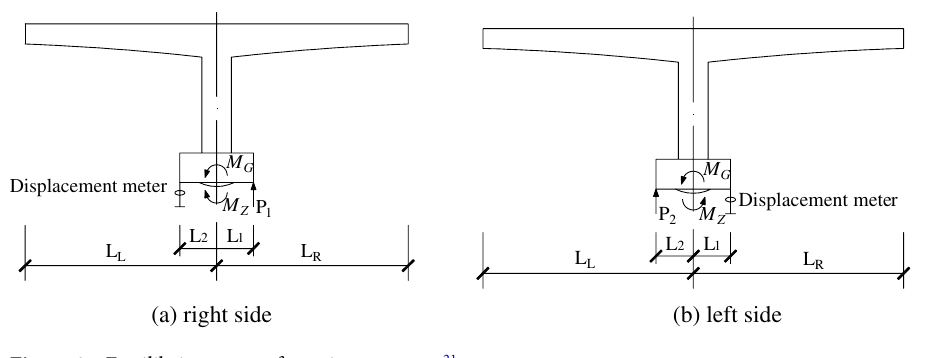
Figure 9. Equilibrium state of rotating structure 21